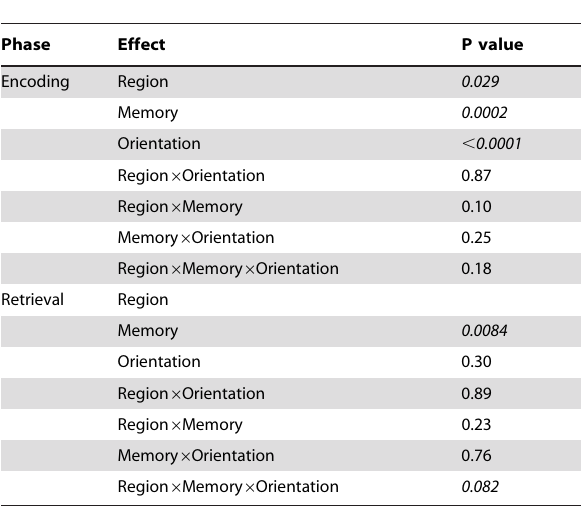
Table 5. Angular gyrus vs. Supramarginal